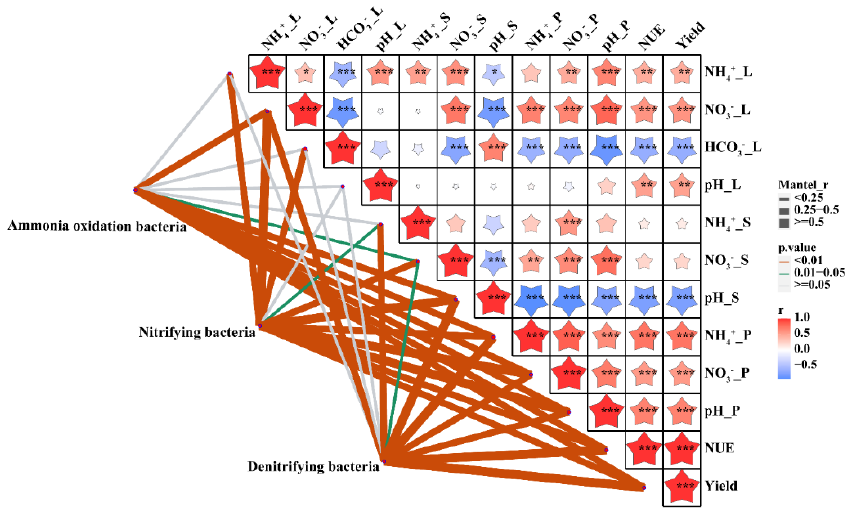
Figure 9. Pairwise comparisons of environmental factors are shown, with a color gradient denoting Spearman’s correlation coefficient. Taxonomy is based on two independent methods: diversity and OTUs of difference potential genera was related to each environmental factor by partial (geographic distance corrected) Mantel tests. Edge width corresponds to Mantel’s r statistic for the corresponding distance correlations, and edge color denotes the statistical significance based on 9999 permutations. “*” represents a correlation between the two indicators, “**” means a significant correlation between the two indicators, and “***” means a very significant correlation between the two indicators. NO 3 − _L: